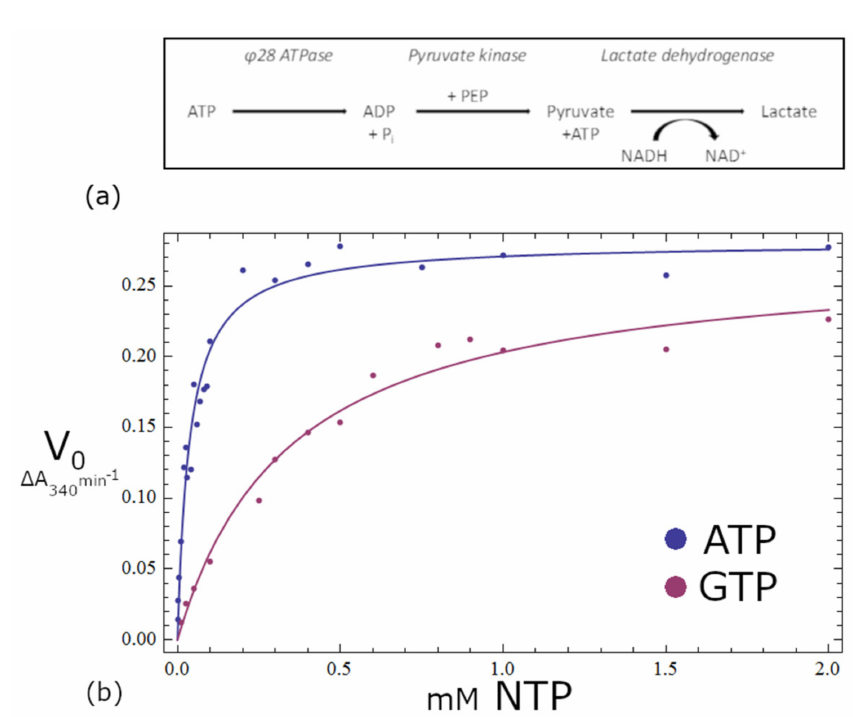
Figure 7. Steady-state kinetics for the ascc ϕ 28 encapsidation protein. ( a ) The gp11 ATPase produces ADP from ATP. Two subsequent enzymatic steps result in the conversion of NADP to NAD+, which is measured with a spectrophotometer. ATP hydrolysis by gp11 is the limiting reaction step, with all other reactants in large excess, so the ATP hydrolysis rate can be correlated with the measured reduction in NADP. ( b ) The upper blue plot represents the ATP substrate, and the lower magenta plot represents GTP. The 10-fold lower K m for ATP indicates that gp11 is primarily an